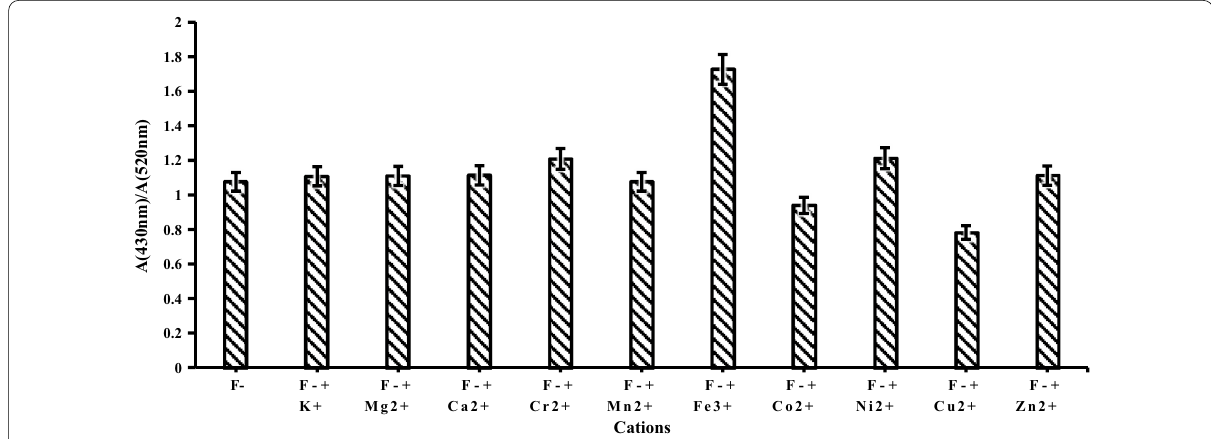
Fig. 8 Effect of interference from equimolar concentration of cations (0.1 mM each)